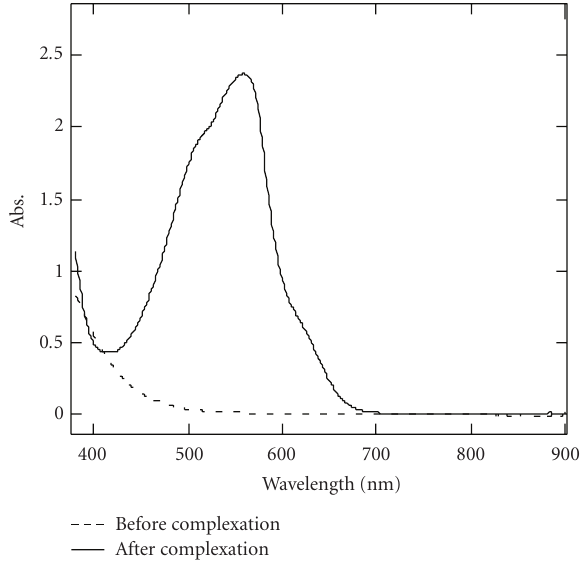
Figure 4: UV-Vis spectra of tpy-PEG-PLeu before and after complexation with Fe 2+